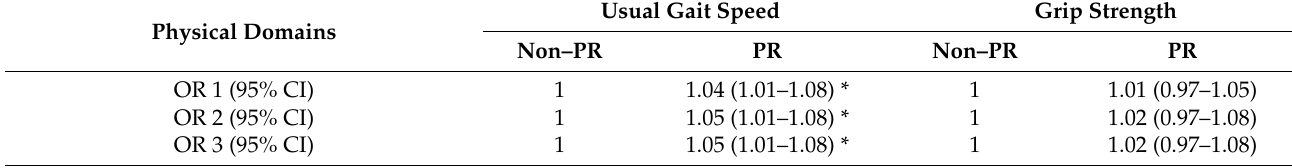
Table 2. Odds ratios and 95% confidence intervals for productive roles according to frailty.